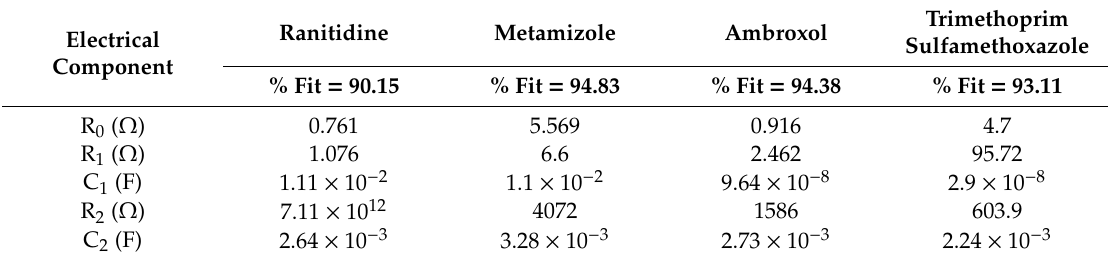
Table 7. Summary of results: best feasible estimated electrochemical